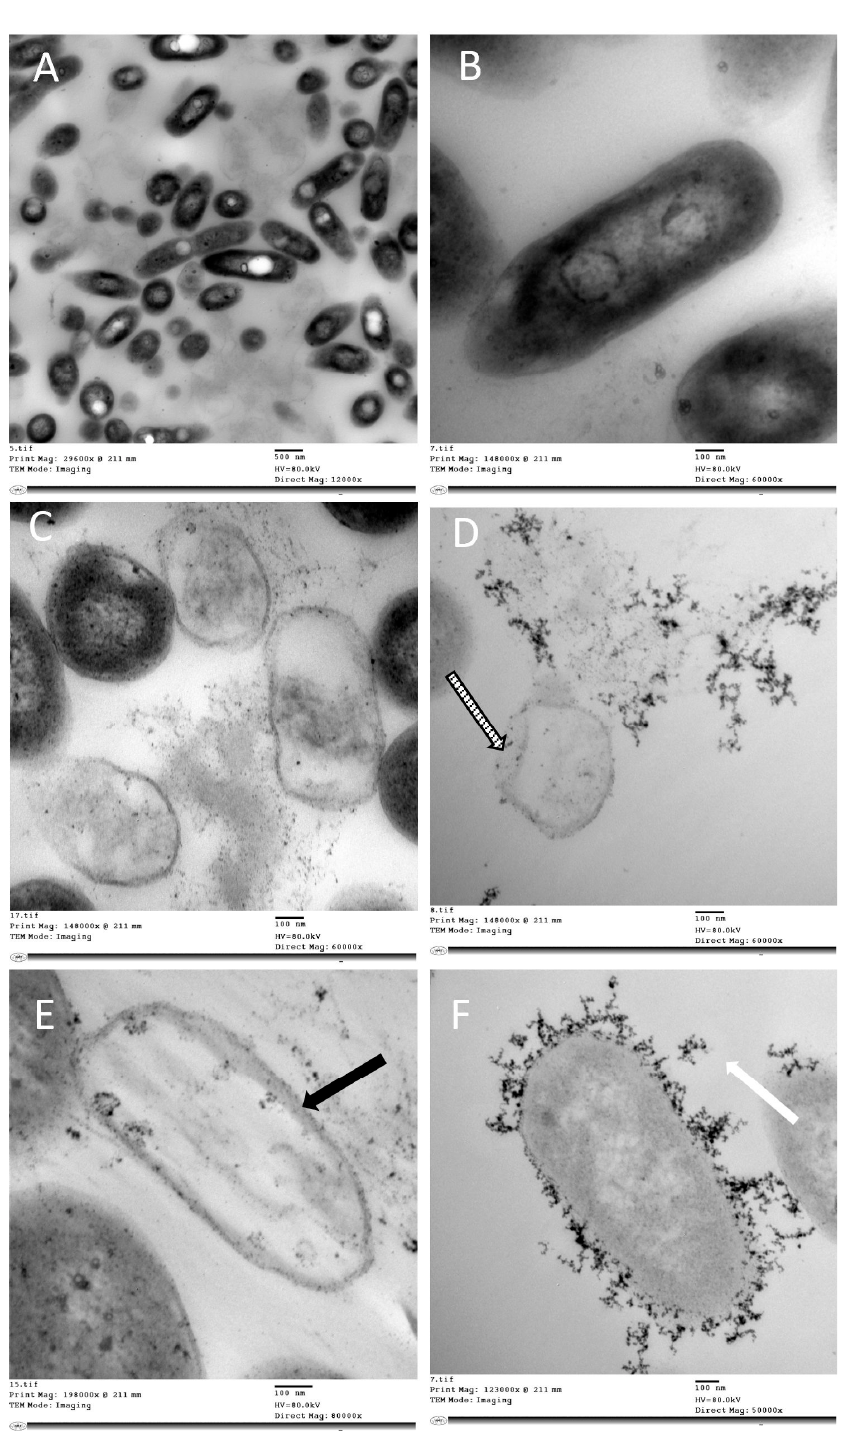
Figure 5. TEM images presenting the structural changes in Acinetobacter baumannii after treatment with rhamnolipid nano-micelles at concentrations less than the MIC. Images ( A , B ) show a normal cell wall outline without any itching or degradation, and with normal intracellular components. Image ( C ) is an overview of the field showing abnormal cell morphology. Images ( D – F ) present the possible antibacterial mechanisms of the rhamnolipid nano-micelles solution: ( D ) abnormal, degraded, itched, and permeabilized cell wall (stripped arrow); ( E ) ghost cell showing loss of intracellular components (black arrow); and ( F ) the presence of amorphous electron-dense materials (white arrow).